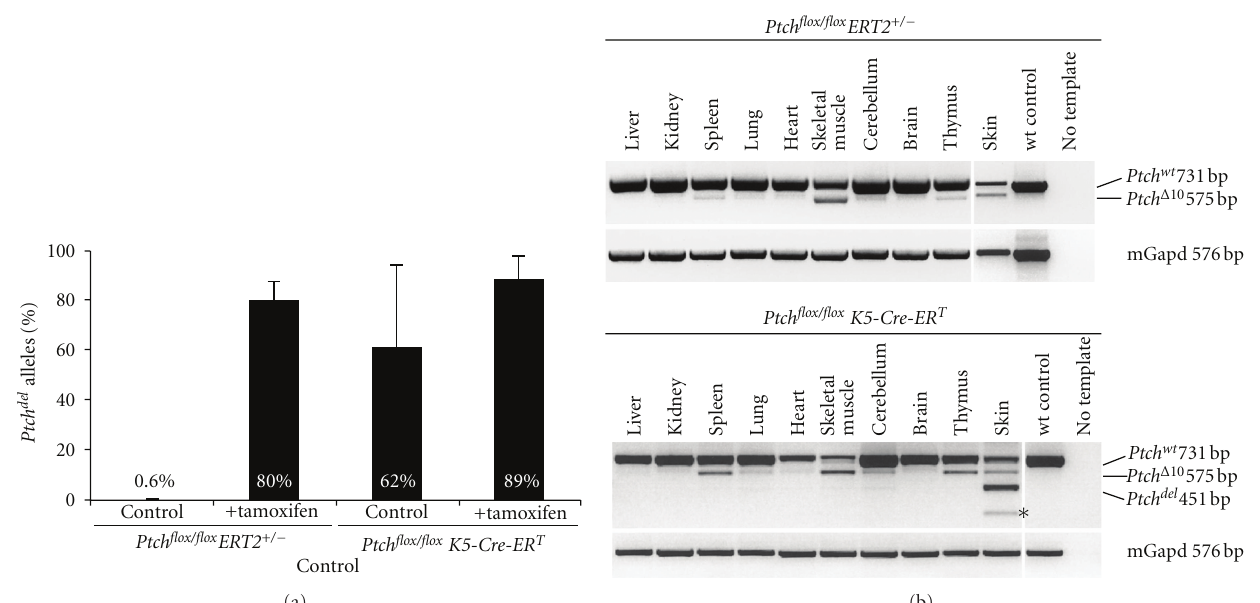
Figure 2: Ptch recombination and expression in Ptch flox/flox ERT 2 + / − and Ptch flox/flox K 5- Cre - ER T mice. (a) The e ffi ciency of loxP recombination at the Ptch locus in DNA derived from tail skin from untreated and tamoxifen treated mice was determined by allele-specific real-time PCR as described in [85]. (b) Ptch transcripts in di ff erent tissues were analyzed by RT-PCR. The transcripts derived from the Ptch flox and the Ptch del locus (the latter equates to the floxed Ptch locus after Cre-mediated excision) were analyzed by semiquantitative RT-PCR as described in [85]. In the skin, untreated Ptch flox/flox ERT 2 + / − mice only expressed Ptch wt transcripts and the normally occurring Ptch Δ 10 transcript lacking exon 10. In contrast, untreated Ptch flox/flox K 5- Cre - ER T mice expressed Ptch del transcripts and Ptch del transcripts lacking exon 10 (asterisk) in the skin.